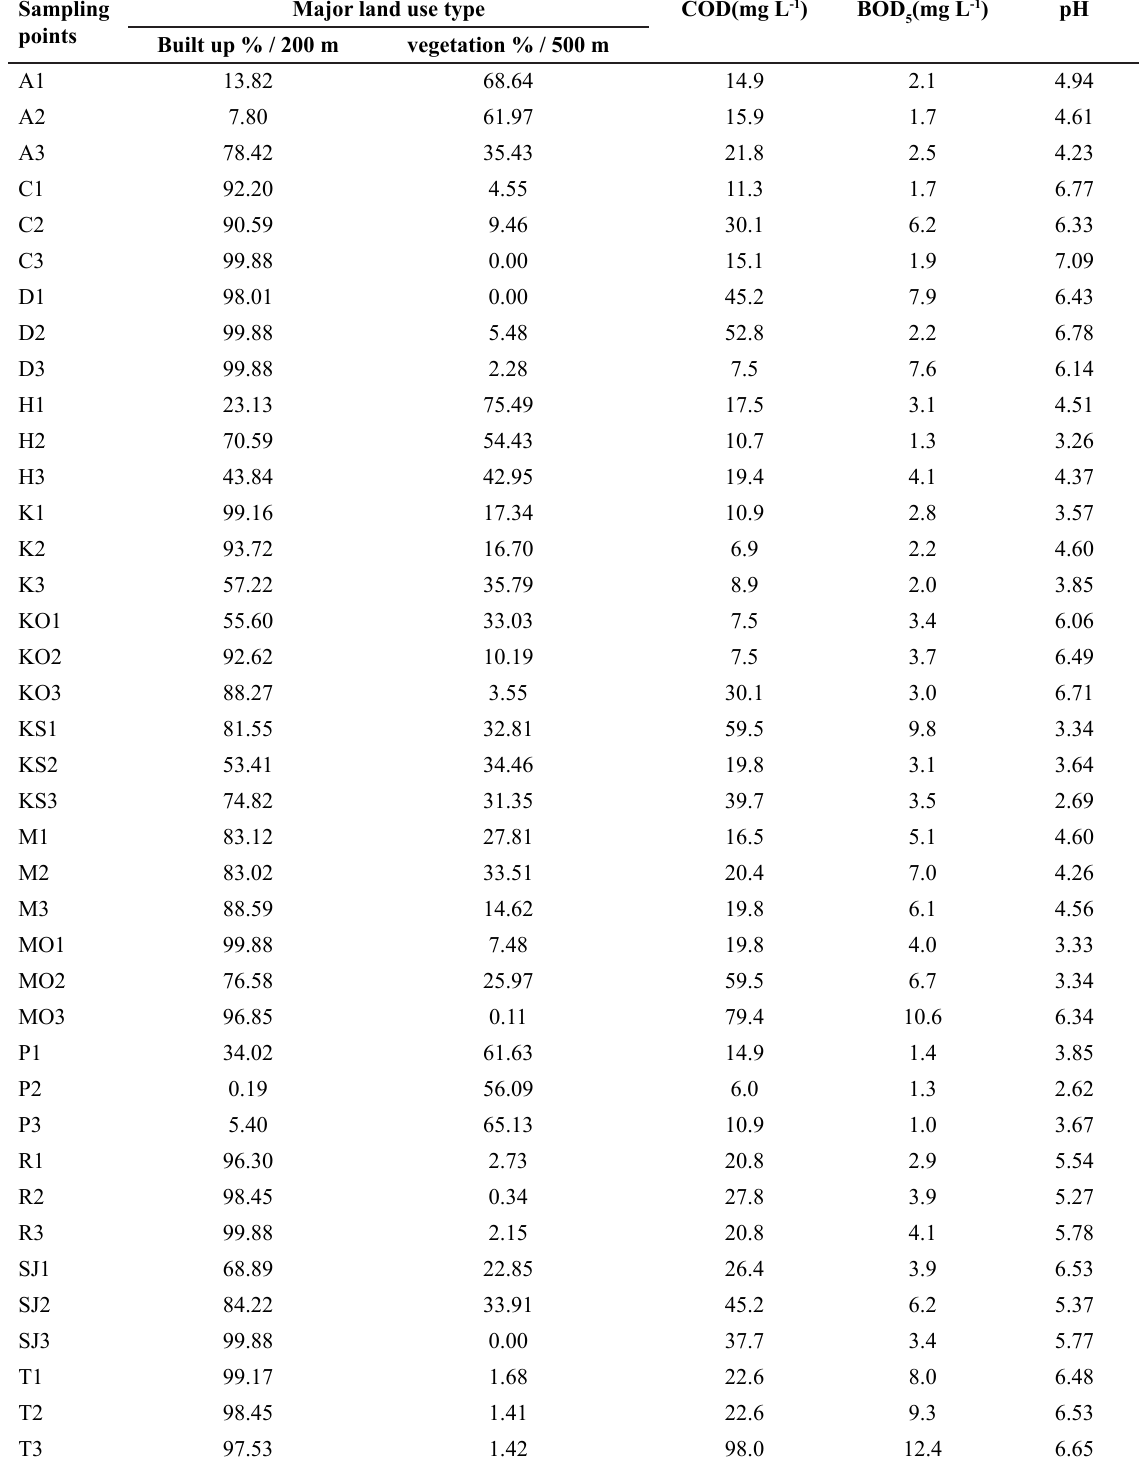
Table 1: As significant and highest coefficient was found in 200 m with COD, BOD the major land use classes and their percentages in the particular buffer zones